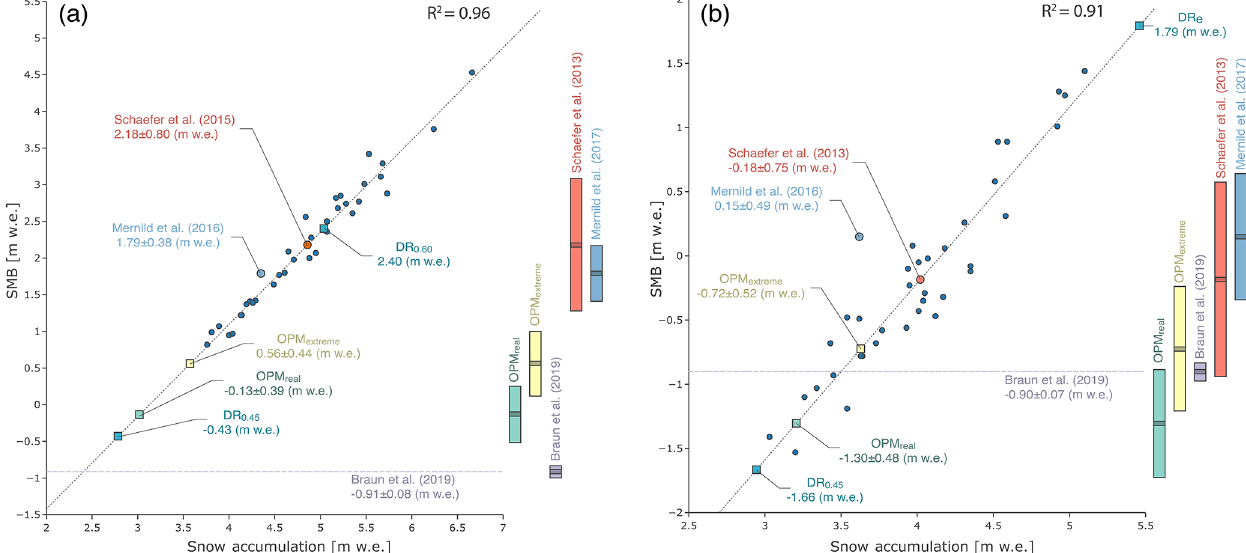
Figure 6. Relation between the annual specific accumulation and surface mass balance over the SPI (a) and NPI (b) . The dark blue dots show the annual SMB values from 1975 to 2000 for the SPI and NPI estimated by Schaefer et al. (2013, 2015). The plot also contains the multi-year mean values of Schaefer et al. (2013, 2015), Mernild et al. (2017), and the SMB values derived from this study (labelled dots). The dashed grey horizontal lines show the geodetic mass balances obtained from radar interferometry (Braun et al., 2019). The uncertainty of the individual studies is shown on the right